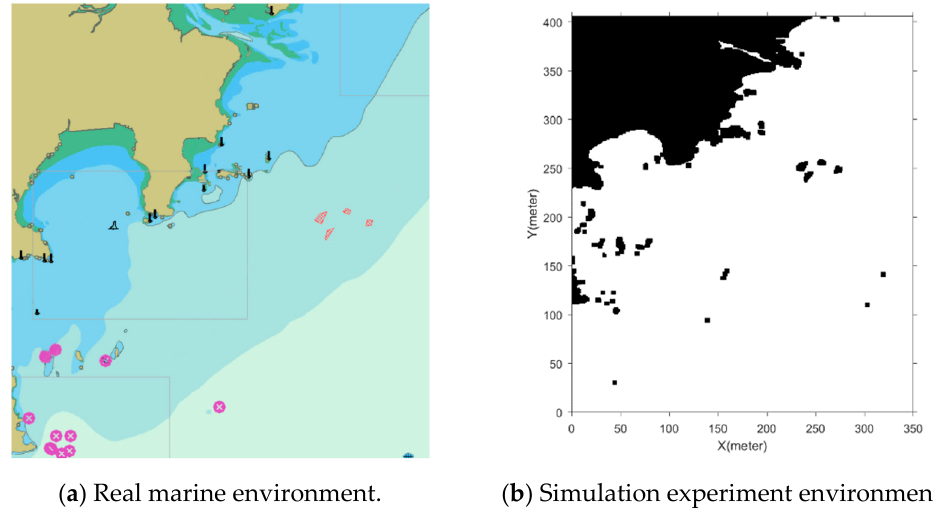
Figure 7. Two-dimensional simulation training marine environment: ( a ) real marine environment; ( b ) simulation experiment environment.